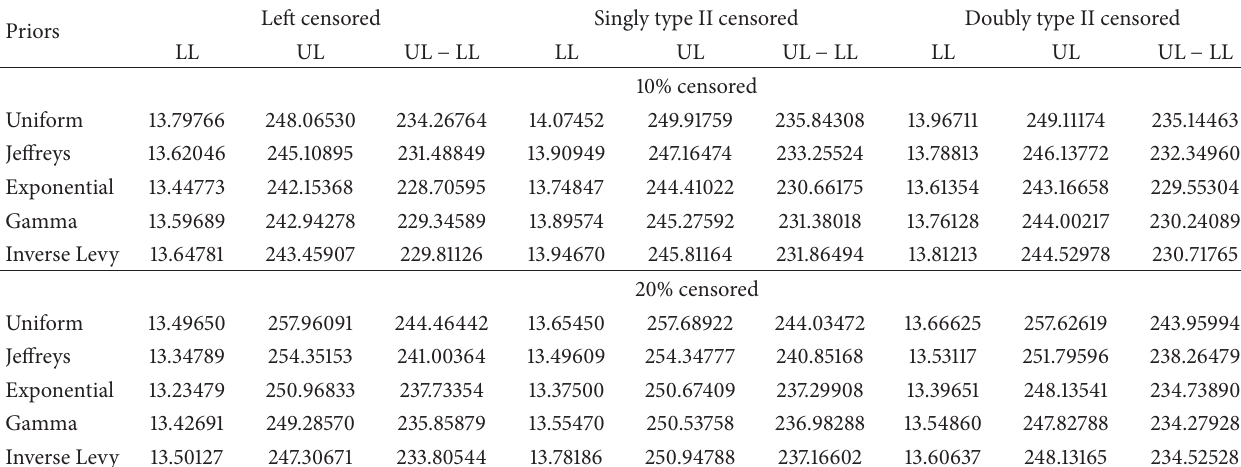
Table 10: 95% posterior predictive intervals under real life